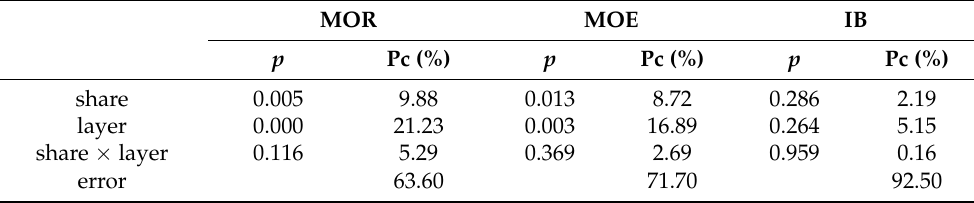
Table 4. Statistical significance of factor influence on mechanical properties of particleboards.